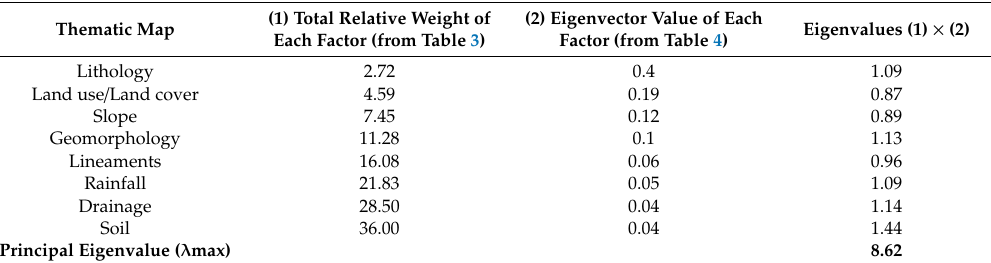
Table 5. Calculation of the principal Eigenvalue to rank parameter influence.